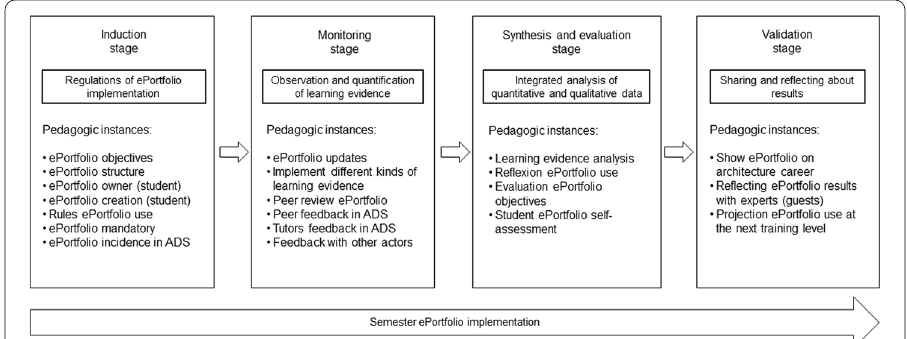
Fig. 1 Sequential stages for ePortfolio implementation in the ADS. Source: Authors’